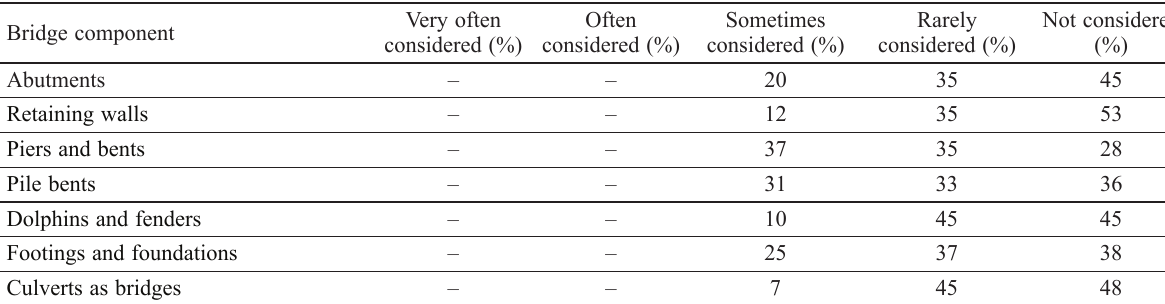
Table 4. NDT usage for bridge substructure components Bridge